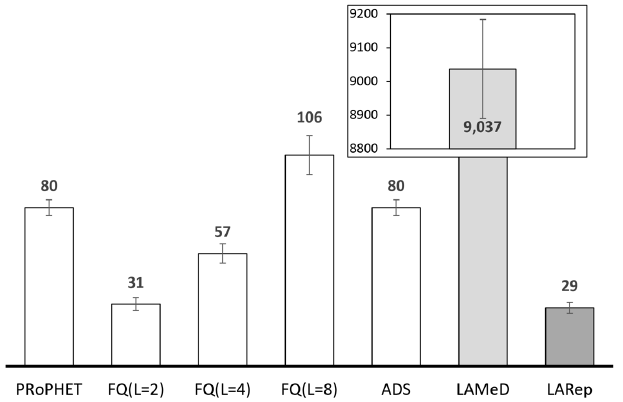
Figure 19. Number of failed transmissions (aka. aborted messages in ONE simulator) in the Skudai scenario.